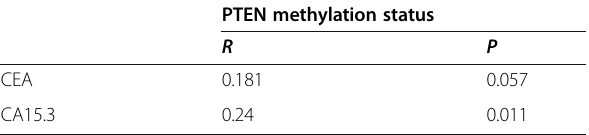
Table 4 Correlation between PTENM status and tumor markers in breast cancer group ( n =